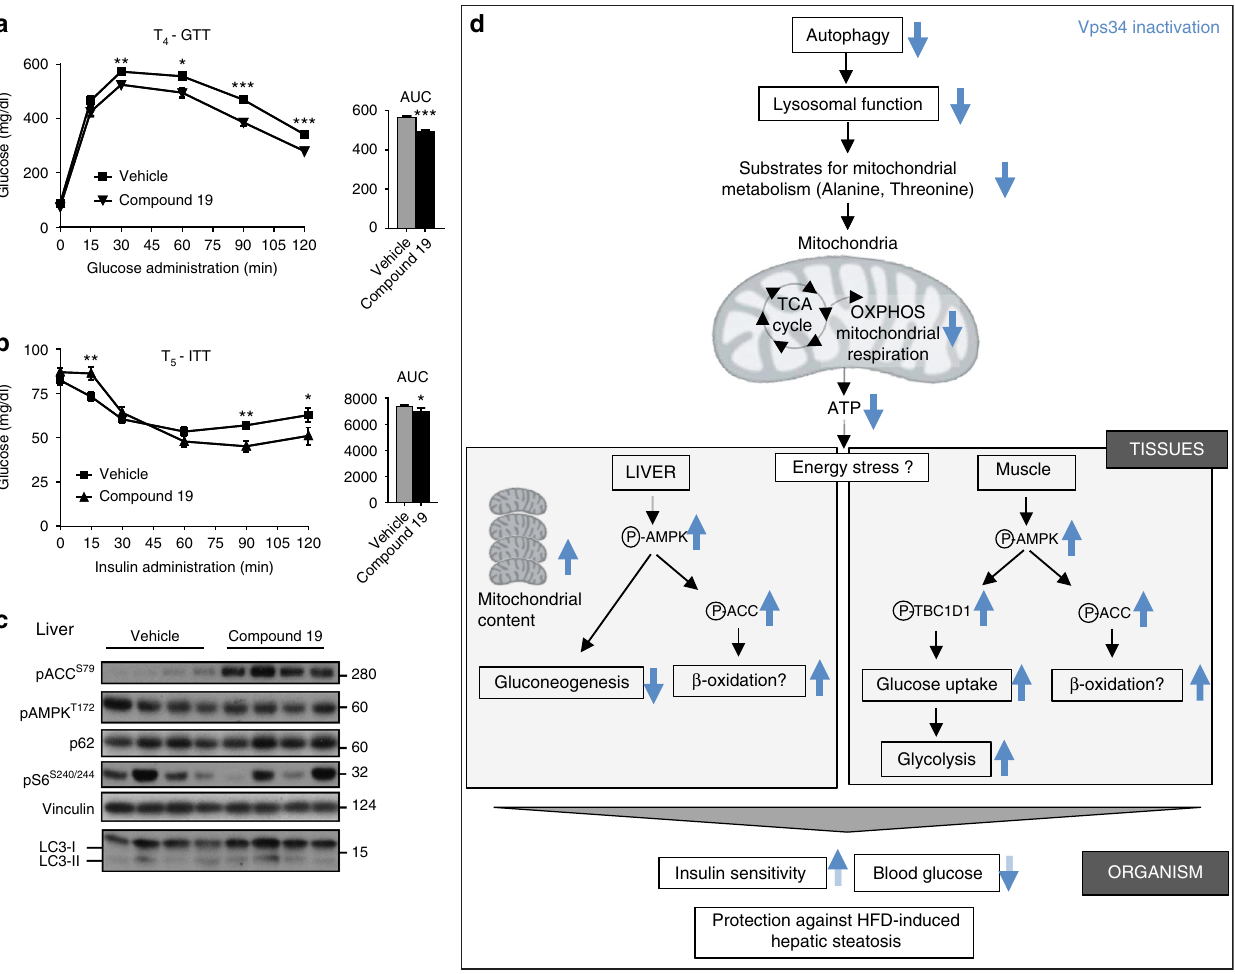
Fig. 10 Impact of pharmacological inhibition of Vps34 on insulin resistance in 60% HFD-fed mice. a GTT after intraperitoneal injection of 2 g/kg of glucose after overnight starvation in 60% HFD-fed mice treated with compound 19 for 4 weeks. Data represent mean ± SEM (non-parametric Mann – Whitney t - test). 10 – 12 mice/genotype. * p < 0.05, ** p < 0.01, *** p < 0.001. b ITT after intraperitoneal injection of 0.75 U/kg of insulin after overnight starvation in 60% HFD-fed mice treated with compound 19 for 5 weeks. Area under the curve (AUC) is shown adjacent to the graph. Data represent mean ± SEM (non- parametric Mann – Whitney t -test). 10 – 12 mice/genotype. p < 0.05, ** p < 0.01, *** p < 0.001. c Tissue homogenates from liver isolated from overnight- starved mice were immunoblotted using the indicated antibodies. Each lane represents an individual mouse. 60 µ g of protein was loaded per lane.